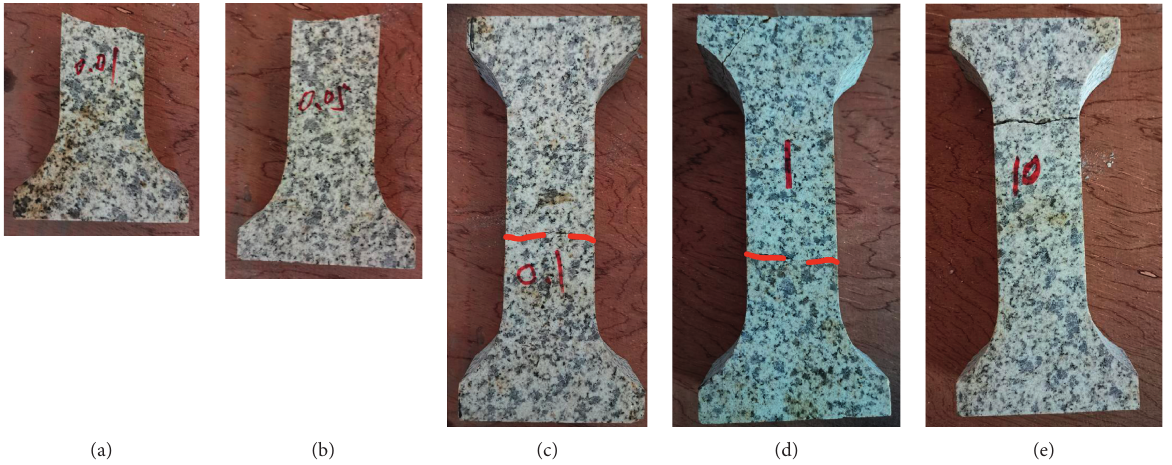
Figure 3: Typical failures after DTtests: (a–e) rock failures for the loading rates of 0.01, 0.05, 0.1, 1, and 10 mm/min, respectively, for the rust